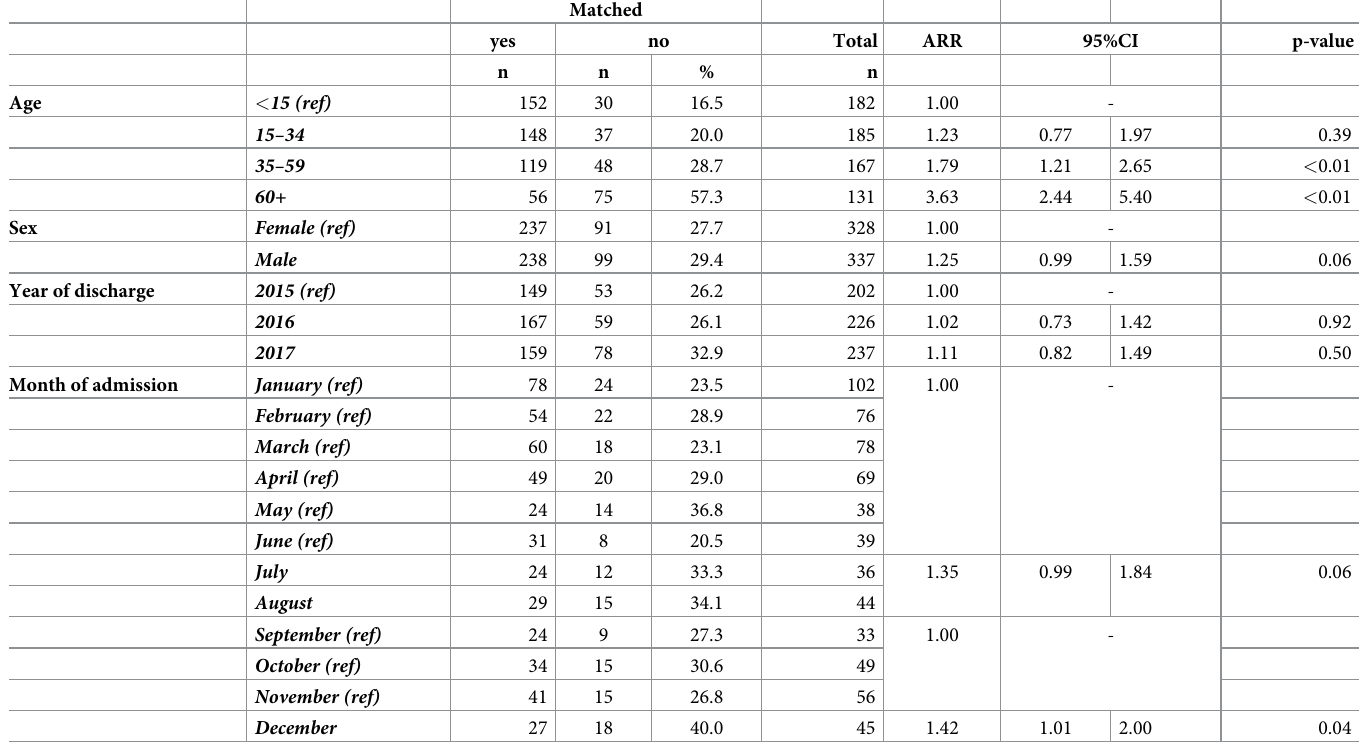
Table 5. Characteristics of hospitalizations for Invasive Meningococcal Diseases (IMD), characteristics and Adjusted Risk Ratios (ARR) of being unmatched with IMD Italian surveillance, hospital discharge registry, Italy,